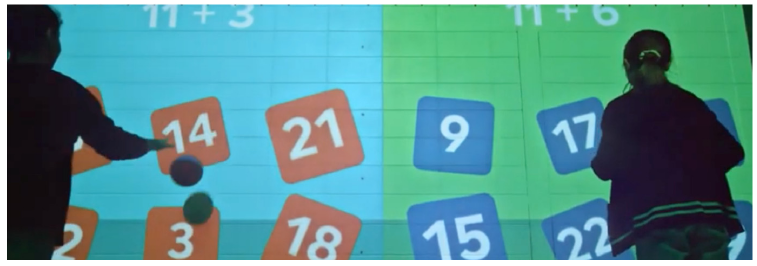
Figure 1. Interactive playground [7].